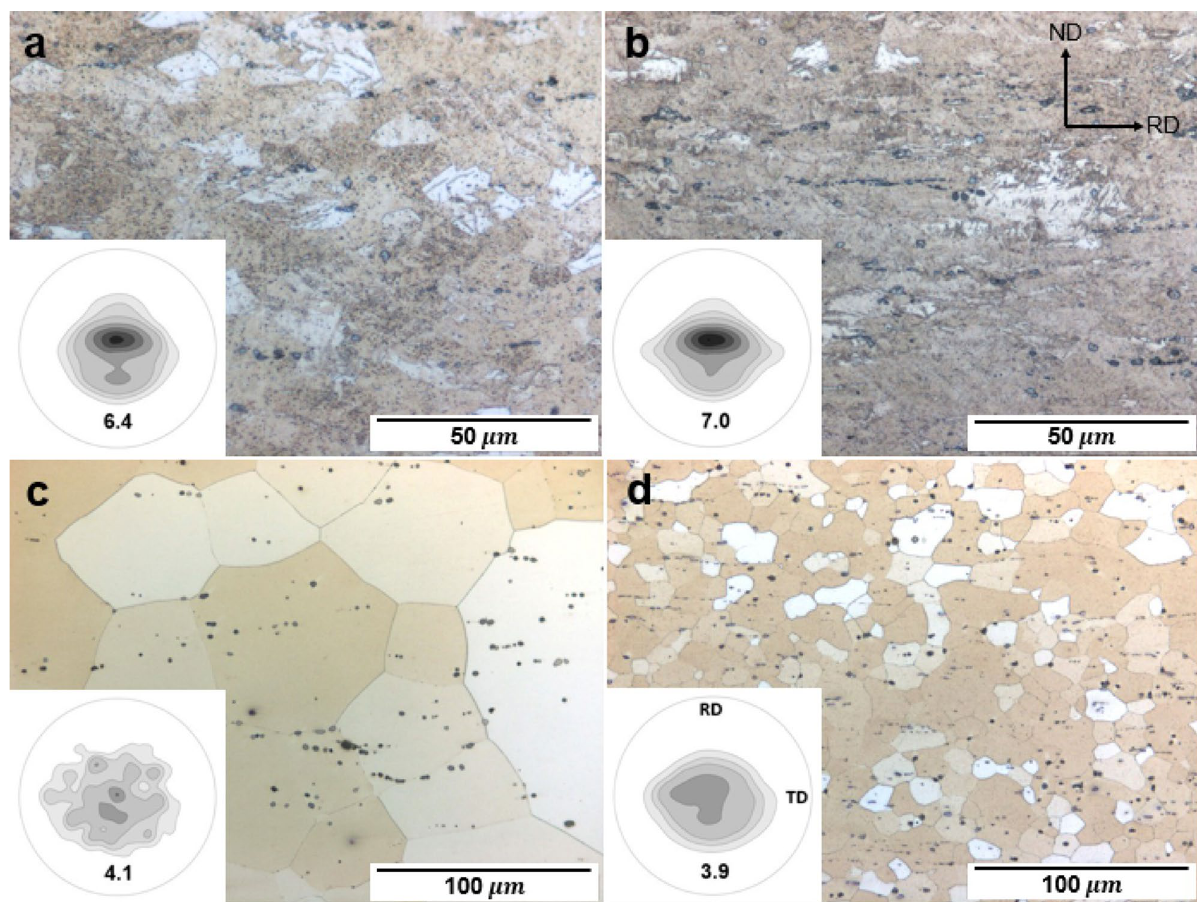
Figure 2. Optical micrographs and corresponding (0002) pole figures of ( a , b ) as-rolled and ( c , d ) homogenized AX10 and AXW100 alloys, respectively. Maximum pole densities of the (0002) pole density = 6.4, 7.0, 4.1 and 3.9 m.r.d. (multiple of random distribution), respectively.